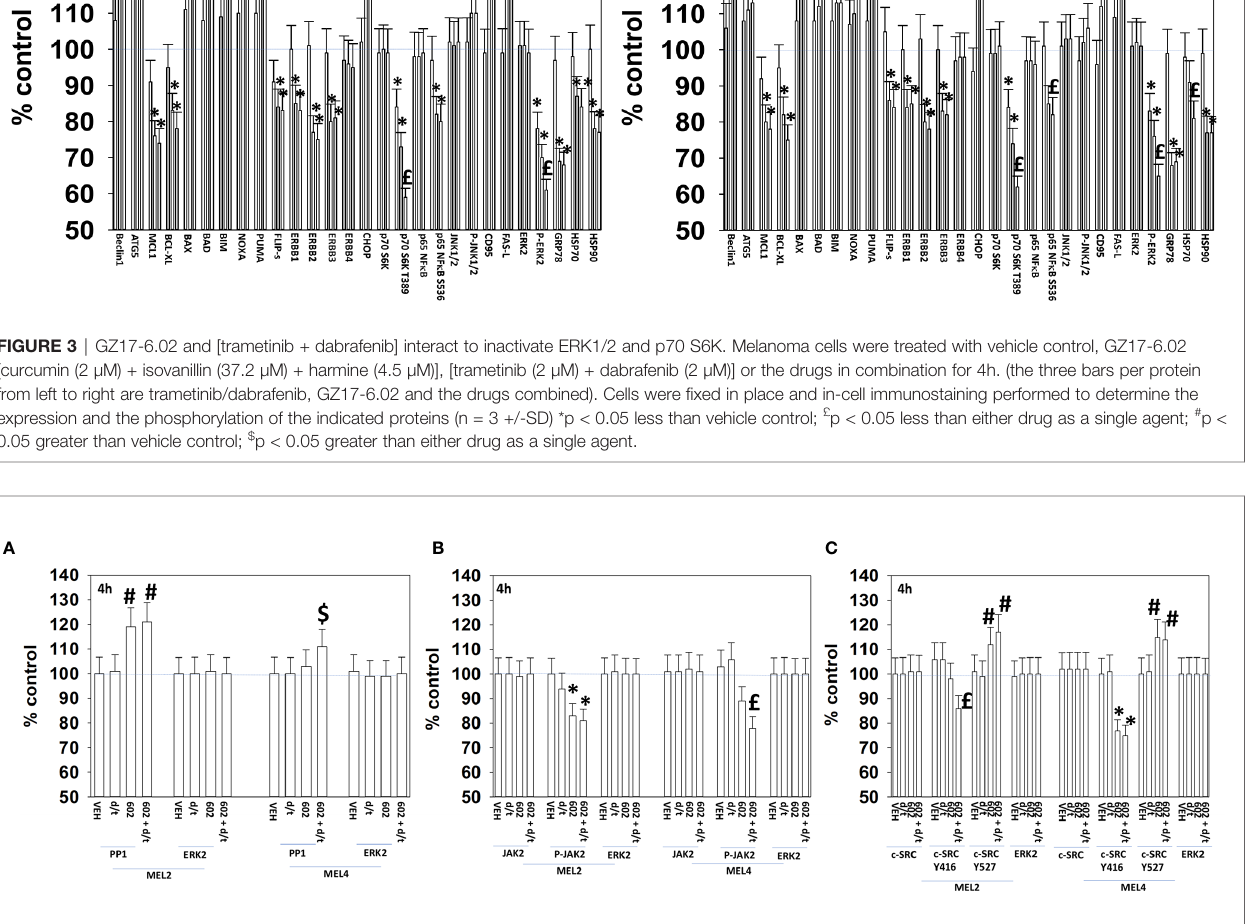
FIGURE 4 | GZ17-6.02 and [trametinib + dabrafenib] can interact to inactivate c-SRC and JAK2 and increase expression of protein serine/threonine phosphatase 1. (A – C) Melanoma cells were treated with vehicle control, GZ17-6.02 [curcumin (2 µM) + isovanillin (37.2 µM) + harmine (4.5 µM)], [trametinib (t, 2 µM) + dabrafenib (d, 2 µM)] or the drugs in combination for 4h. Cells were fi xed in place and in-cell immunostaining performed to determine the expression and the phosphorylation of the indicated proteins (n = 3 +/-SD) *p < 0.05 less than vehicle control; £ p < 0.05 less than either drug as a single agent; # p < 0.05 greater than vehicle control; $ p < 0.05 greater than either drug as a single agent.